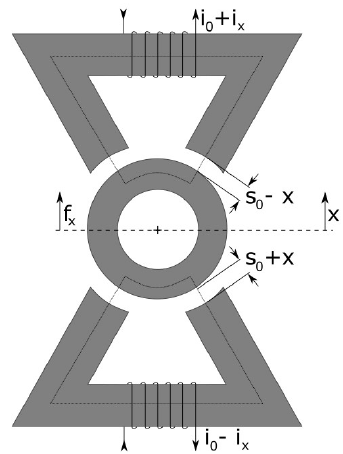
Figure 2. Differential driving mode of an axial bearing.